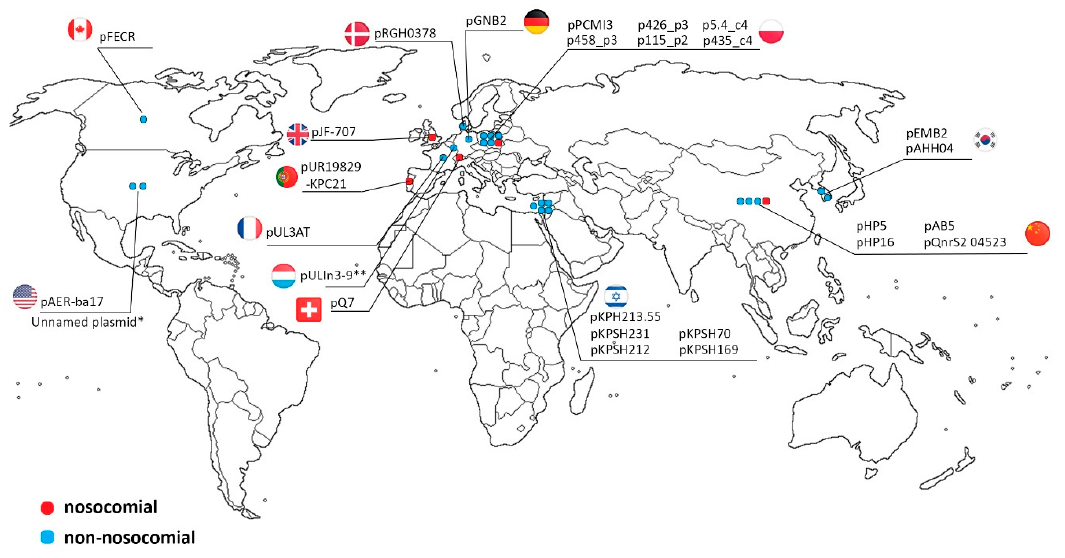
Figure 3. Biogeography of IncQ-3 plasmids: Blue dots—plasmids isolated from non-nosocomial environments; red dots—plasmids isolated from nosocomial environments.